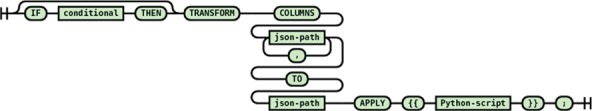
Syntax diagram for the multiple path many-to-one transformation statement.